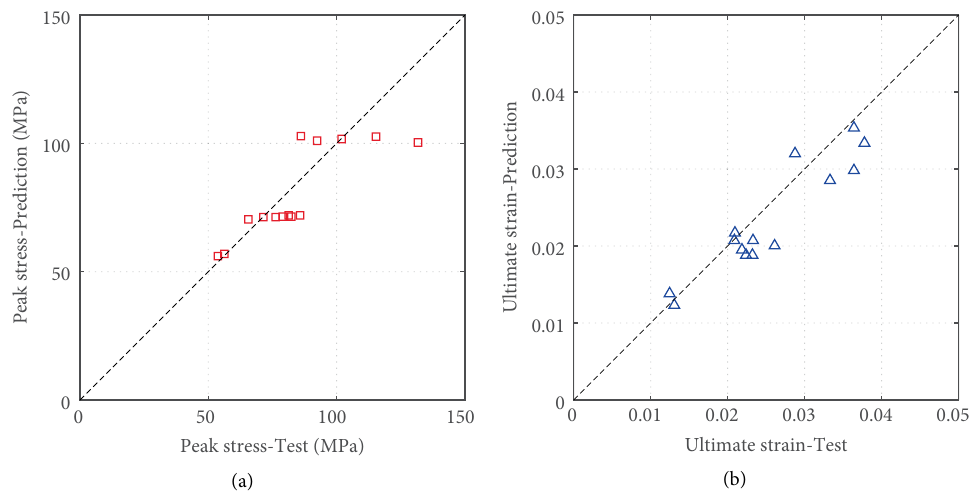
Figure 14: Predictions of the proposed model. (a) Peak stress. (b) Ultimate